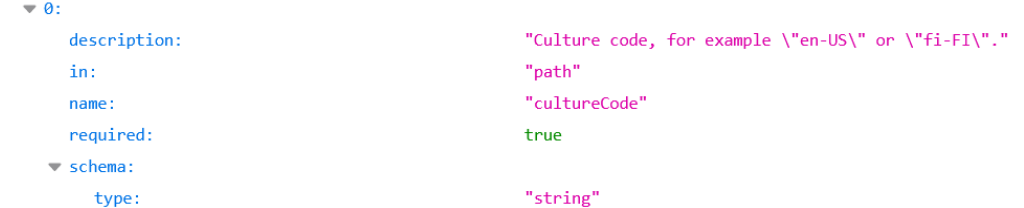
Figure 4. Descriptive values for API parameters.